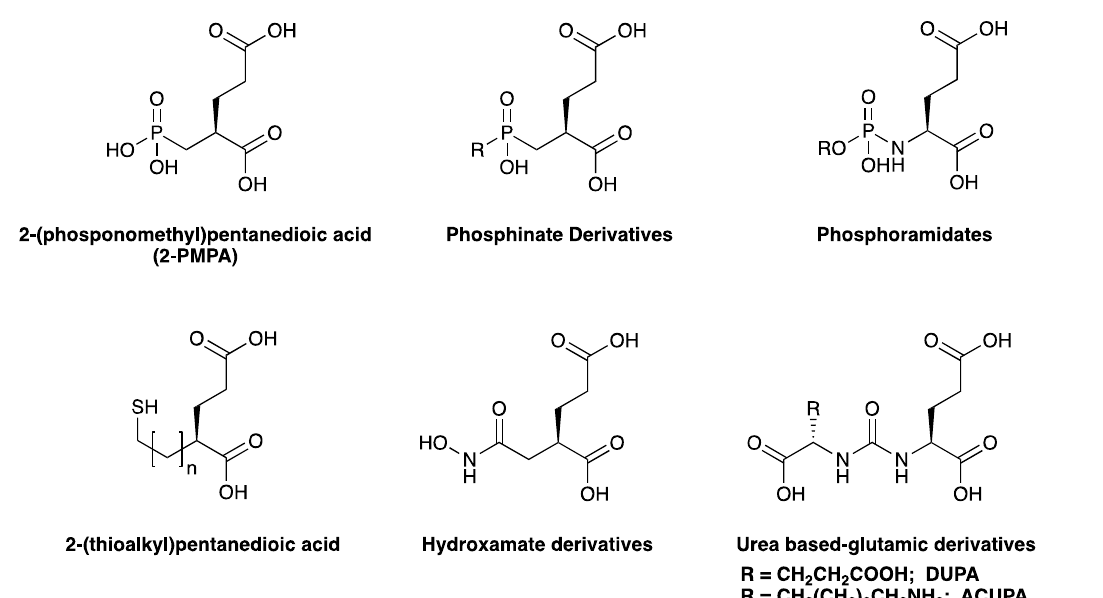
Figure 2. Chemical structures of main classes of small molecule-based PSMA-targeting ligands.